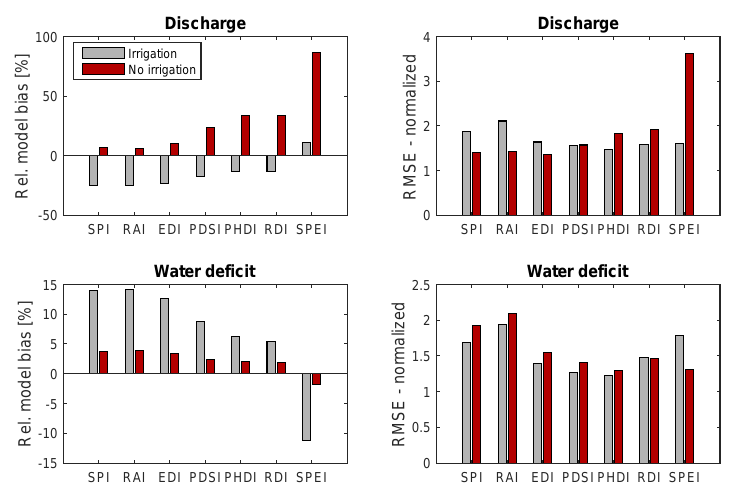
Figure 7. Relative model bias and NRMSE in the NOIRR and PIRR/FUTIRR irrigation scenarios. The results are based on the average of the outputs of the four regional climate models (Table 2).